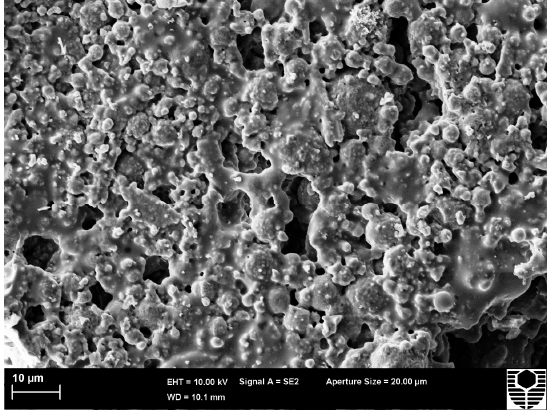
Figure 8. HTC 6A post compression test at 700 °C image.